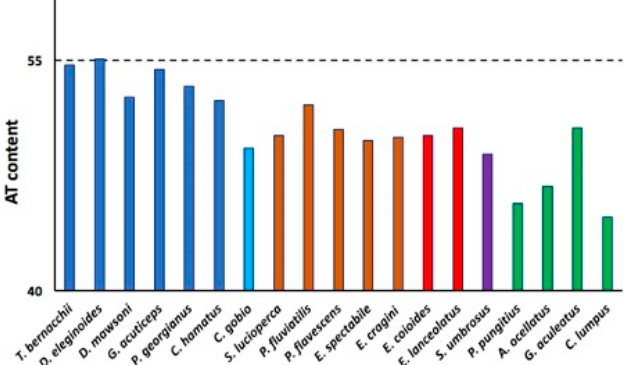
Figure 7. Percentage of AT content of the pIgR exons of Antarctic species (blue bars) and the non- Antarctic notothenioid species C. gobio (light blue bar) compared to representative species of the temperate perciform suborders Percoidei (brown bars), Serranoidei (red bars), Scorpaenoidei (purple bar), and Cottoidei (green